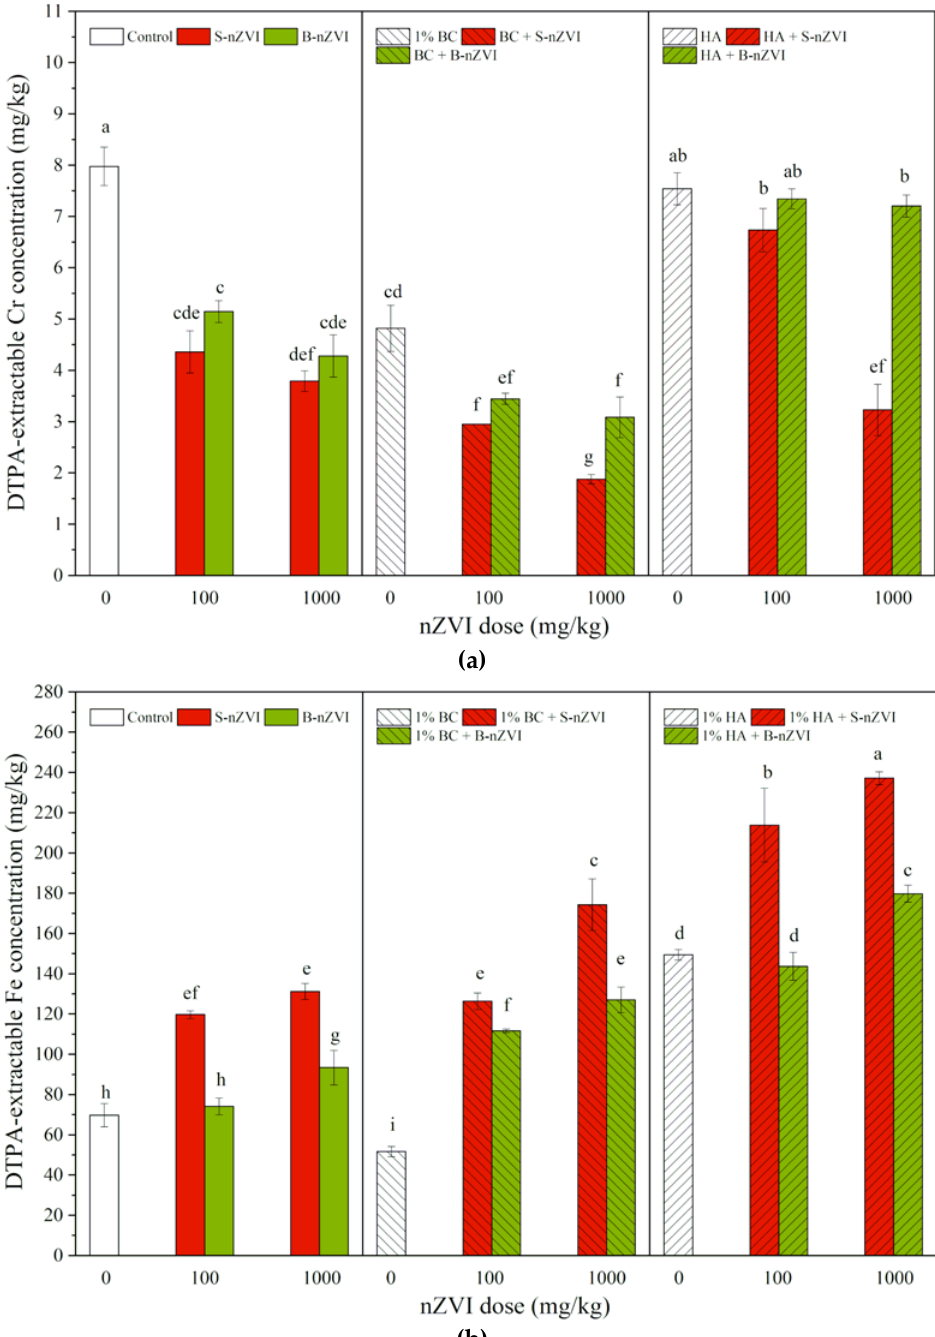
Figure 2. DTPA-extractable Cr ( a ) and Fe ( b ) concentrations (means ± SD, n = 4) in soil with nZVI alone or in combination with BC or HA. Different letters on the bars indicate significant differences among all means in different treatments using a one-way ANOVA followed by a Duncan’s multiple range test ( p < 0.05). Three-way ANOVA results are shown in Table 2.